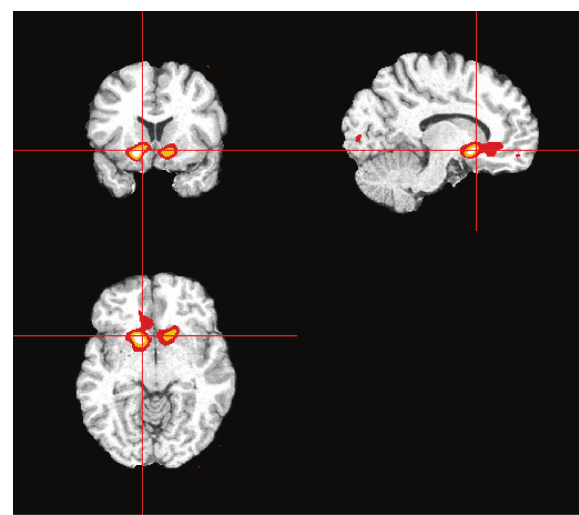
Figure 4: Largest significant clusters where APOE ε 4/ ε 4 or ε 3/ ε 4 genotypes were associated with less decline in WM volume for statistical maps based on family-wise error rate corrected P value thresholding from permutation testing. Results are shown for relevant coronal (upper left), sagital (upper right) and axial (lower) slices. Statistical significance was based on suprathreshold cluster- level permutation testing. Colors represent voxels satisfying P value thresholds of 0.001, 0.0001, and 0.00001,